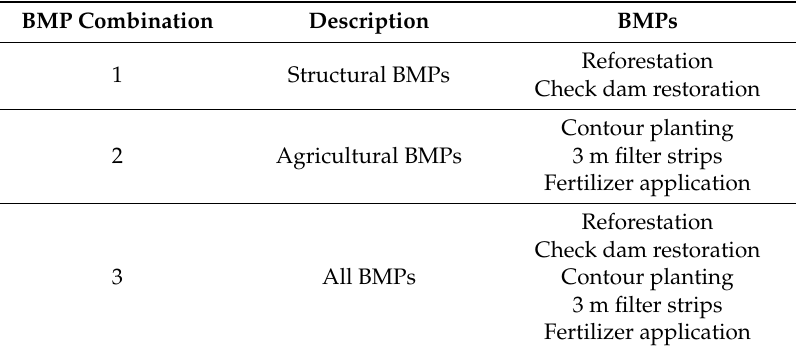
Table 4. Selected Best management Practices (BMPs)